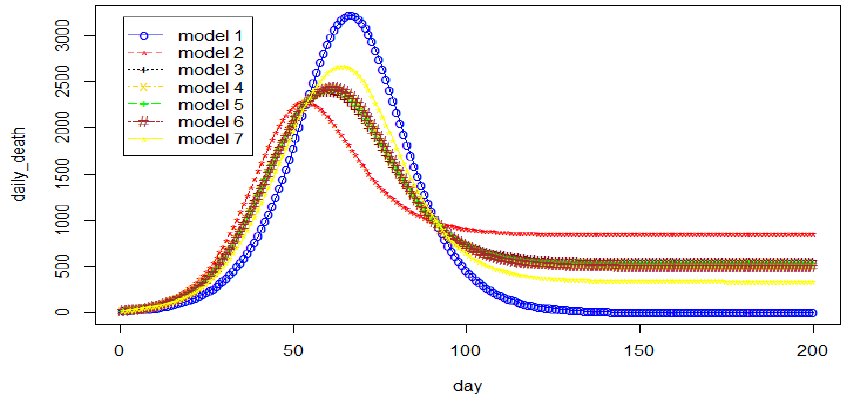
Figure 5. The estimated daily number of deaths vs. day in the United